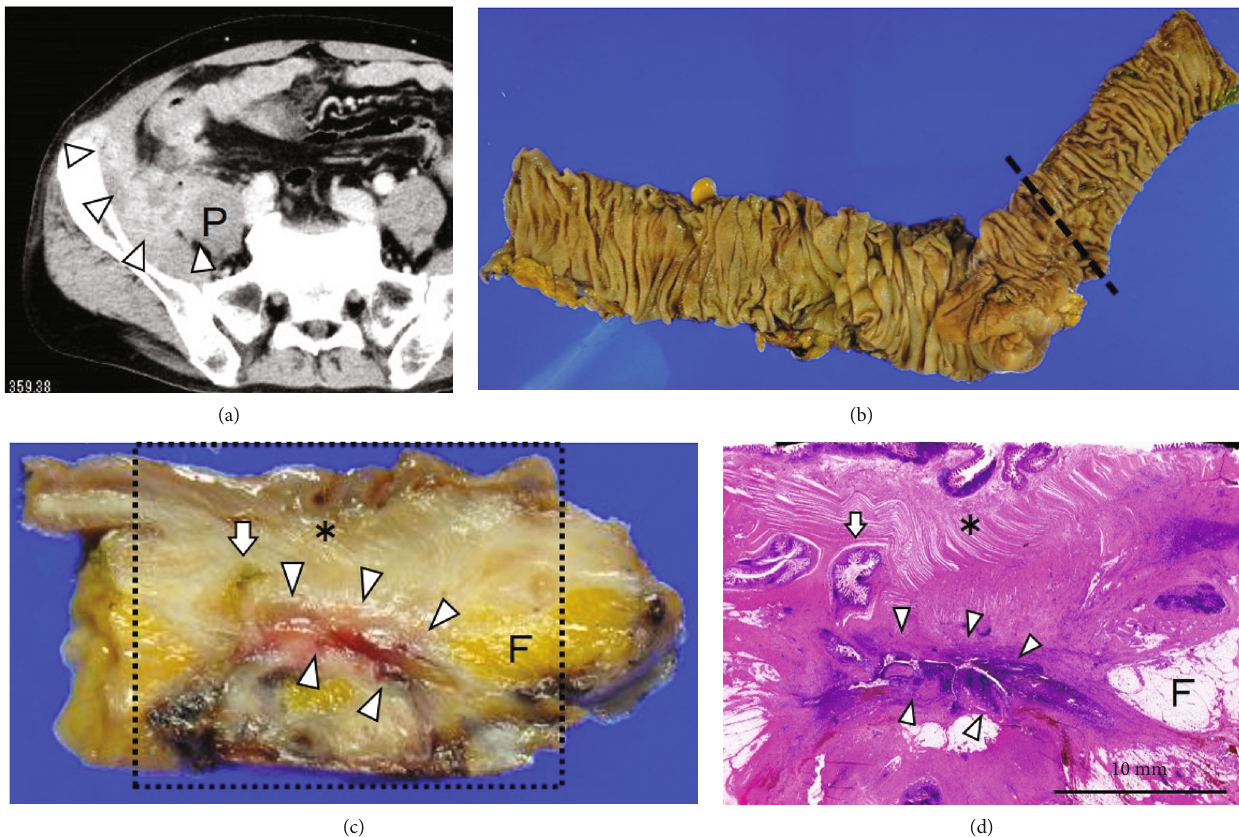
Figure 3: Case 3 fi ndings. (a) CT showed abscess formation by penetration of terminal ileum diverticulitis (arrowheads) into the psoas muscle (P) and retroperitoneum. (b) Resected specimen after ileocecal resection showed the presence of diverticulum. The dotted line represents the cross section line for Figure 3(c). (c, d) Specimen cross section and microscopic examination (H&E) shows terminal ileum diverticulum (asterisk), intestinal mucosa (arrow), in fl ammation area, and intestinal mucosa (arrowheads), and fi brosis area